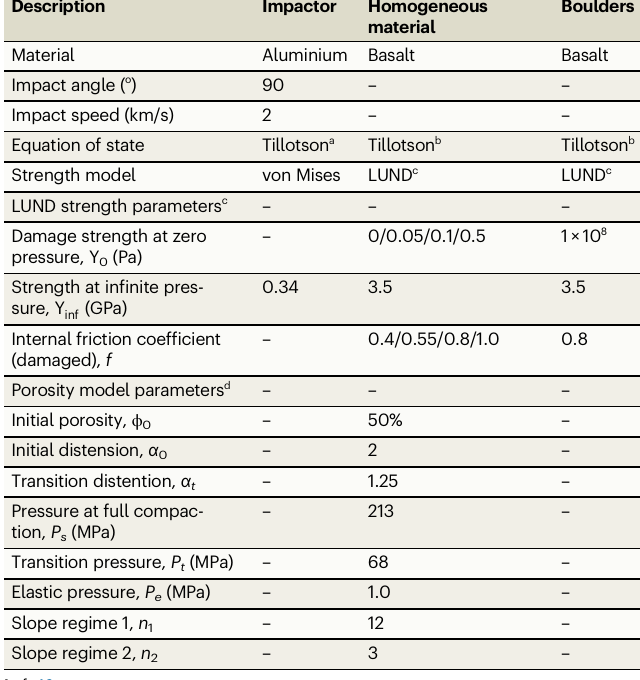
Table 1 | Material model parameters for impact simulations into Ryugu analogues